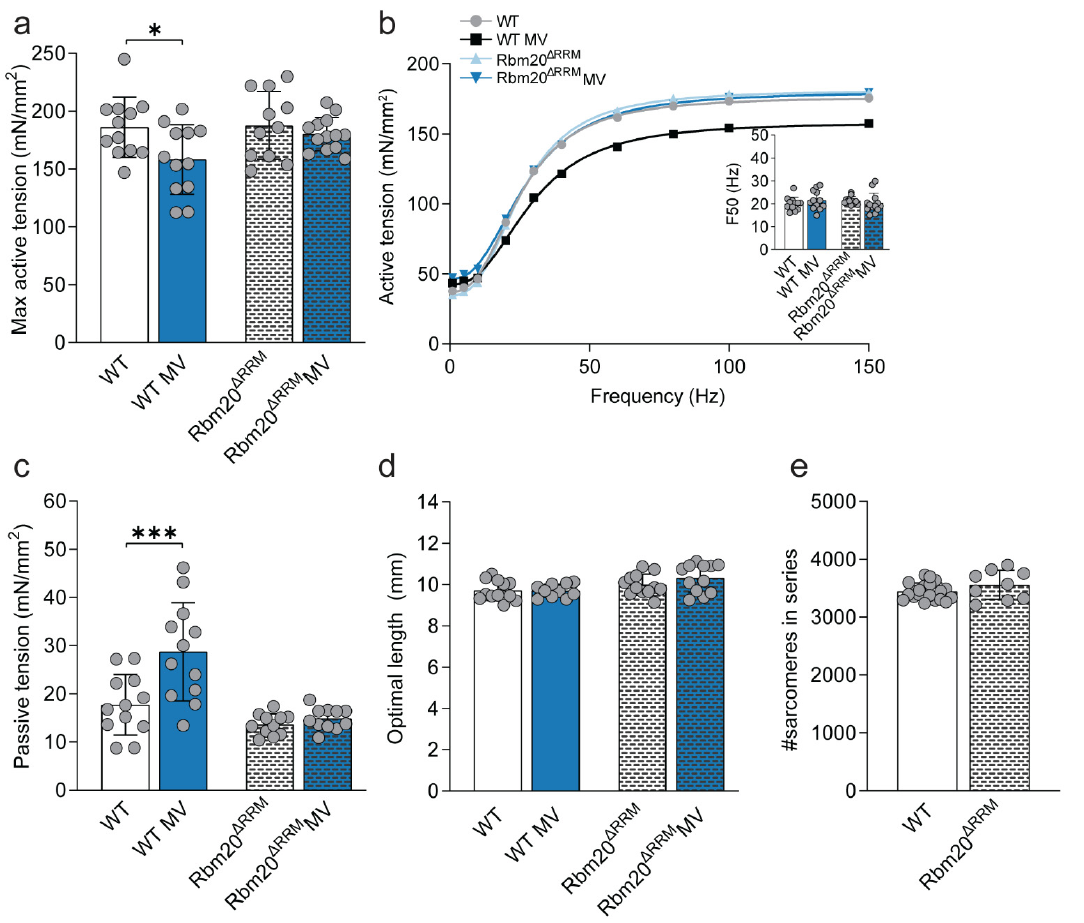
Figure 2. Effects of mechanical ventilation on muscle function in the Rbm20 Δ RRM mouse dia- phragm. ( a ) Maximal active tension of non-ventilated and ventilated WT and the Rbm20 Δ RRM mice. ( b ) Fitted curves for tension-stimulation frequency relations. F50 (inset) was determined as the ab- solute EC50 of the curve, and represents the frequency required to develop 50% of maximal force. ( c ) Passive tension measured at optimal length in non-ventilated and ventilated WT and Rbm20 Δ RRM mice. ( d ) Optimal diaphragm strip length, i.e., the length representing maximal cross bridge binding required for maximal force production. ( e ) Number of sarcomeres in series. Bars represent mean ± SD. * p < 0.05, *** p < 0.001. WT = wild type, MV = mechanically ventilated. Each dot represents a single animal and animals are only presented in each graph once.